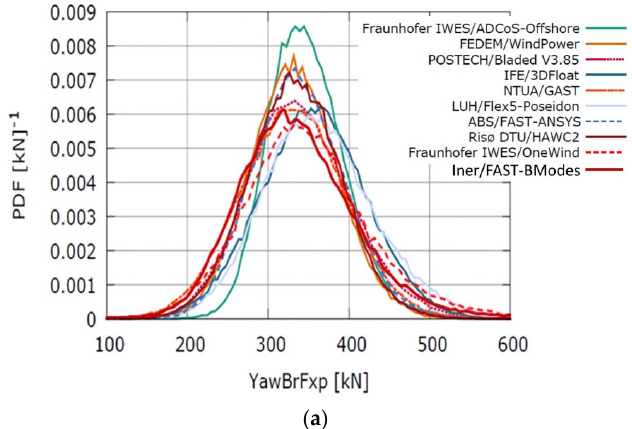
Table 6. Load Cases of OC4 Phase I for Jacket